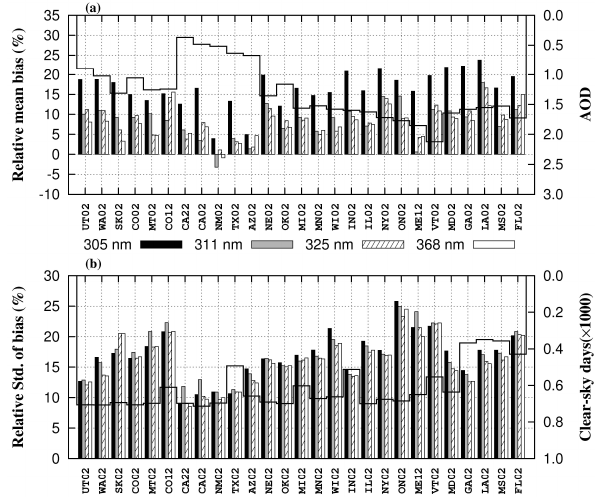
Fig. 7. Same as Fig. 2 except for total-sky